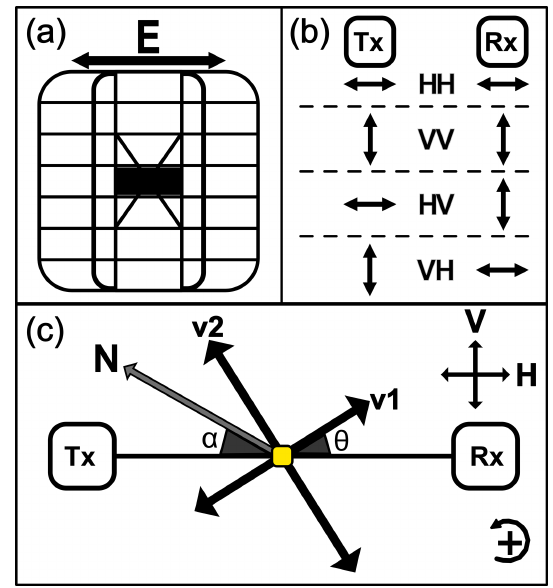
Figure 2. (a) Bird’s-eye view of the ApRES slot antenna with the direction of the electric field vector ( E ). (b) The terminology of the co- and cross-polarized ApRES measurements defined using E . The direction of wave propagation is into the page ( ⊗ ). (c) The model coordinate system where transmitting (Tx) and receiving (Rx) an- tennas are connected with the aerial line (TR). The horizontal (H) and vertical (V) polarization planes are defined so that H is parallel to TR. The directions of the ice fabric horizontal principal axes are represented by v 1 and v 2 . θ is the angle between H and v 1 , and α is used for